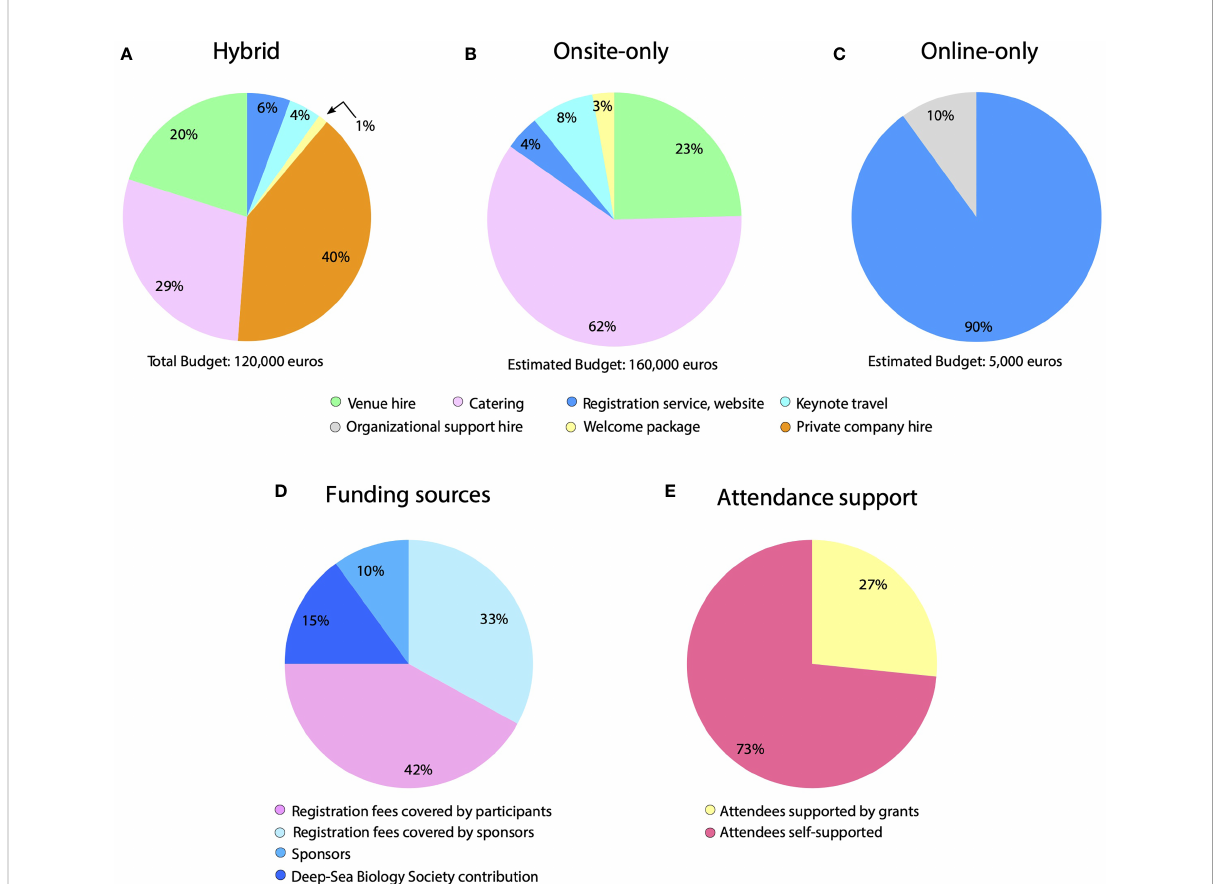
FIGURE 2 Relative contribution (%) of the budget from the three types of conference: (A) hybrid, (B) online only and (C) onsite only. The budget in (A) re fl ects the total costs of the hybrid 16DSBS. Budget estimates are based on a conference with 581 participants: (B) if it was hosted onsite-only at the Oce ́ anopolis Aquarium and (C) if it was organized exclusively online following the budget of eDSBS, an online-meeting (Stefanoudis et al., 2021). Organizational support hire includes costs associated to hire staff member(s) dedicated to the event organization. (D) General proportion of the funding sources for 16DSBS, including the amount of the registration costs covered by sponsors, in particular the DSBS and the International SeaBed Authority. (E) Relative proportion of attendees who were supported by travel grants offered by the DSBS together with the International SeaBed Authority. The total number of participants was